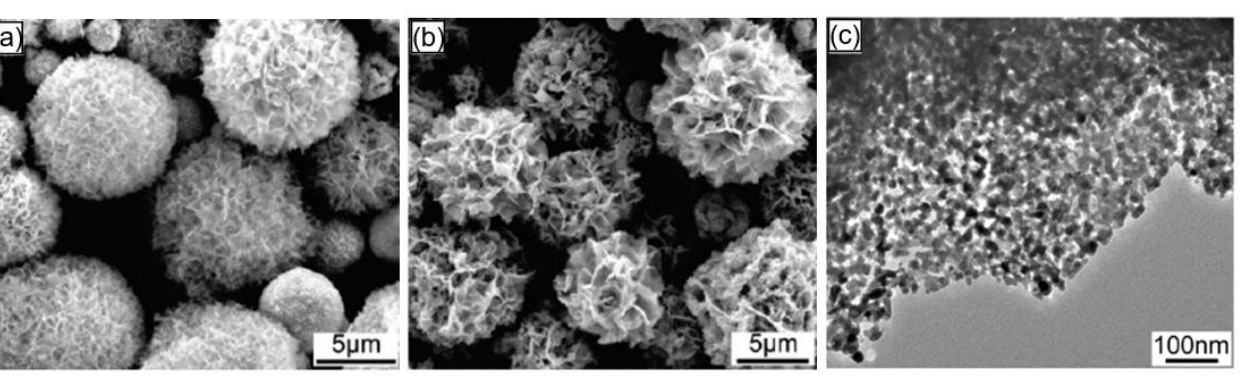
Figure 23. Response of ( a ) unmodified and ( b ) modified with Rh ZnO flower ‐ based sensor to 10 ppm TMA at 220 °C under different RH. Reprinted with permission from Li et al. [153]. Copyright 2022: Elsevier. Chen et al. [155] used bulk doping of ZnO with Fe (0%, 0.5%, 1%, and 3%), carried out during hydrothermal synthesis, to optimize the gas ‐ sensitive properties of ZnO flow ‐ erlike nanostructures. They found that in order to achieve the maximum sensory response to acetone (~105 at 100 ppm) in the temperature range of 250–450 °C, the concentration of Fe should not exceed 0.5%. Otherwise, the sensory response was significantly reduced